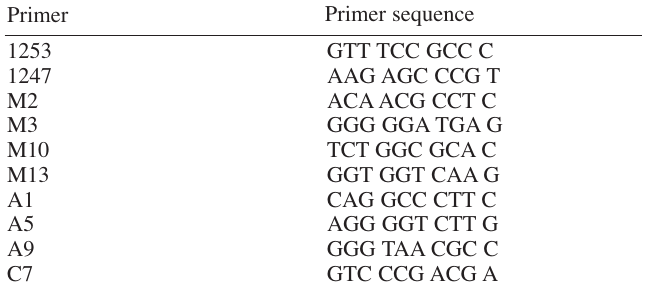
Table 1 - Nucleotide sequences of DNA primers used for RAPD analysis Primer Primer sequence